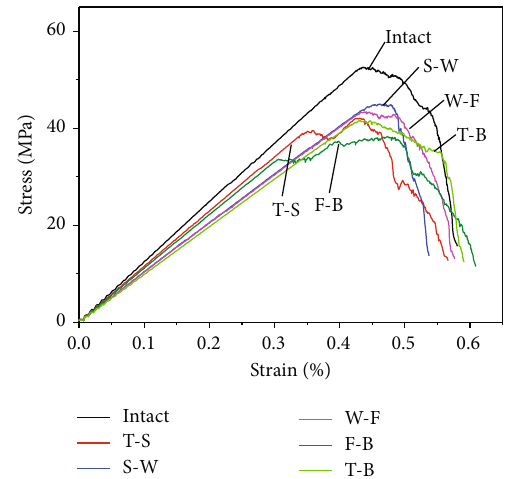
Figure 7: Stress-strain curves of models with double-joint location in di ff erent